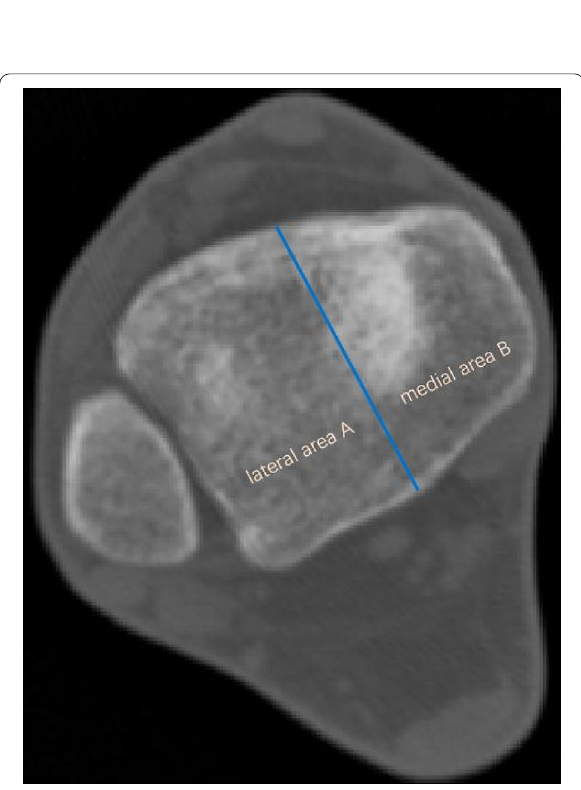
Fig. 3 Division of the tibial plafond: lateral area A and medial area